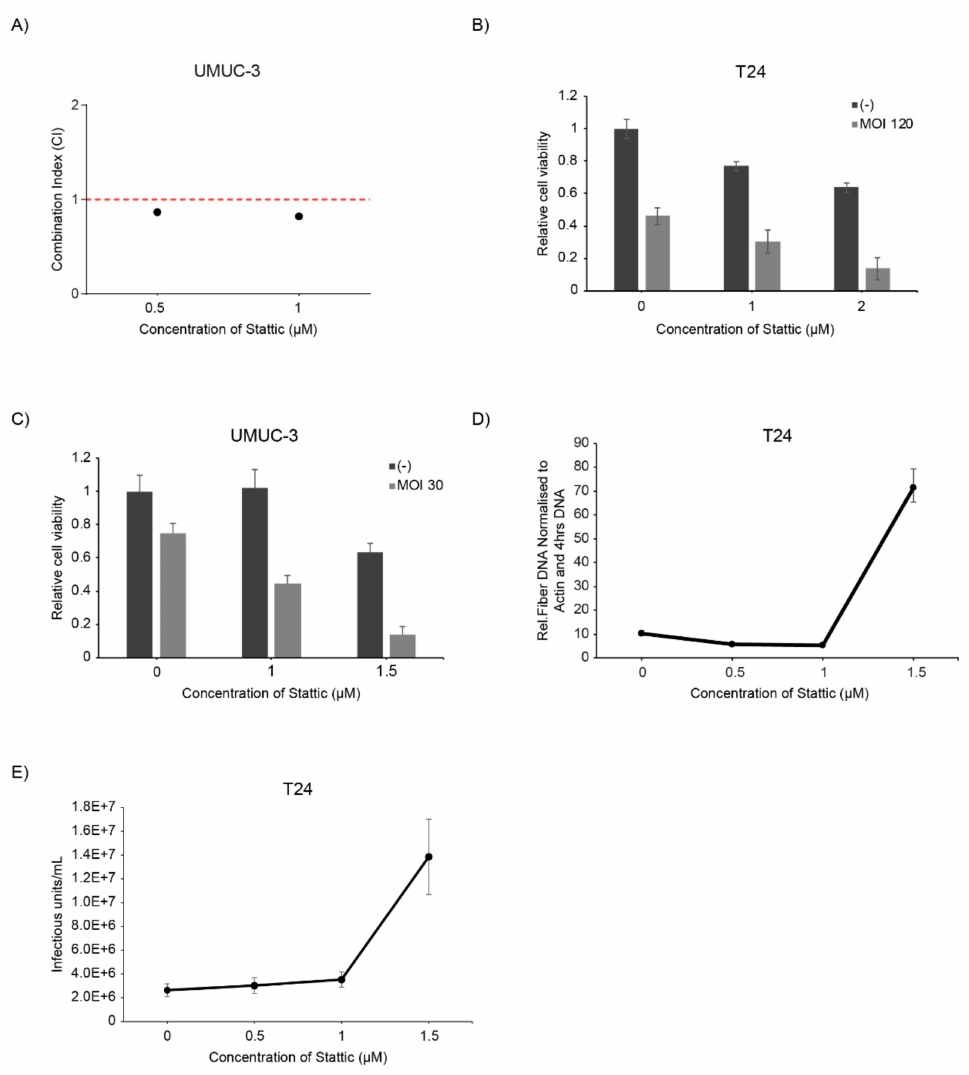
Figure 5. Combination therapy with Stattic and Palbociclib, and oncolytic virotherapy. ( A ) Treatment of the UMUC-3 cells was done for 72 h with Stattic alone at 0.5 µ M and 1 µ M and in a fixed concentration combination with 0.5 µ M Palbociclib. Combination index (CI) for combining Stattic with Palbociclib were plotted. Values were calculated using the Chou-Talalay theorem. ( C ). Cells were treated with Stattic and infected with XVir-N-31 with corresponding multiplicity of infections (MOI) in T24 ( B ) and in UMUC-3 cells ( C ). The MOIs are indicated in the graphs. Cell viability was analysed at 4dpi by sulphorhodamine B assay. Error bars S.E. ( D , E ) T24 cells were infected with XVir-N-31 (MOI 50) and treated with increasing concentrations of Stattic ( D ) Viral replication was analysed at 48 h by qPCR of fibre DNA, and ( E ) the increase in viral titre upon Stattic inhibition is measured by hexon titre test and represented as infectious units / mL (IFU /